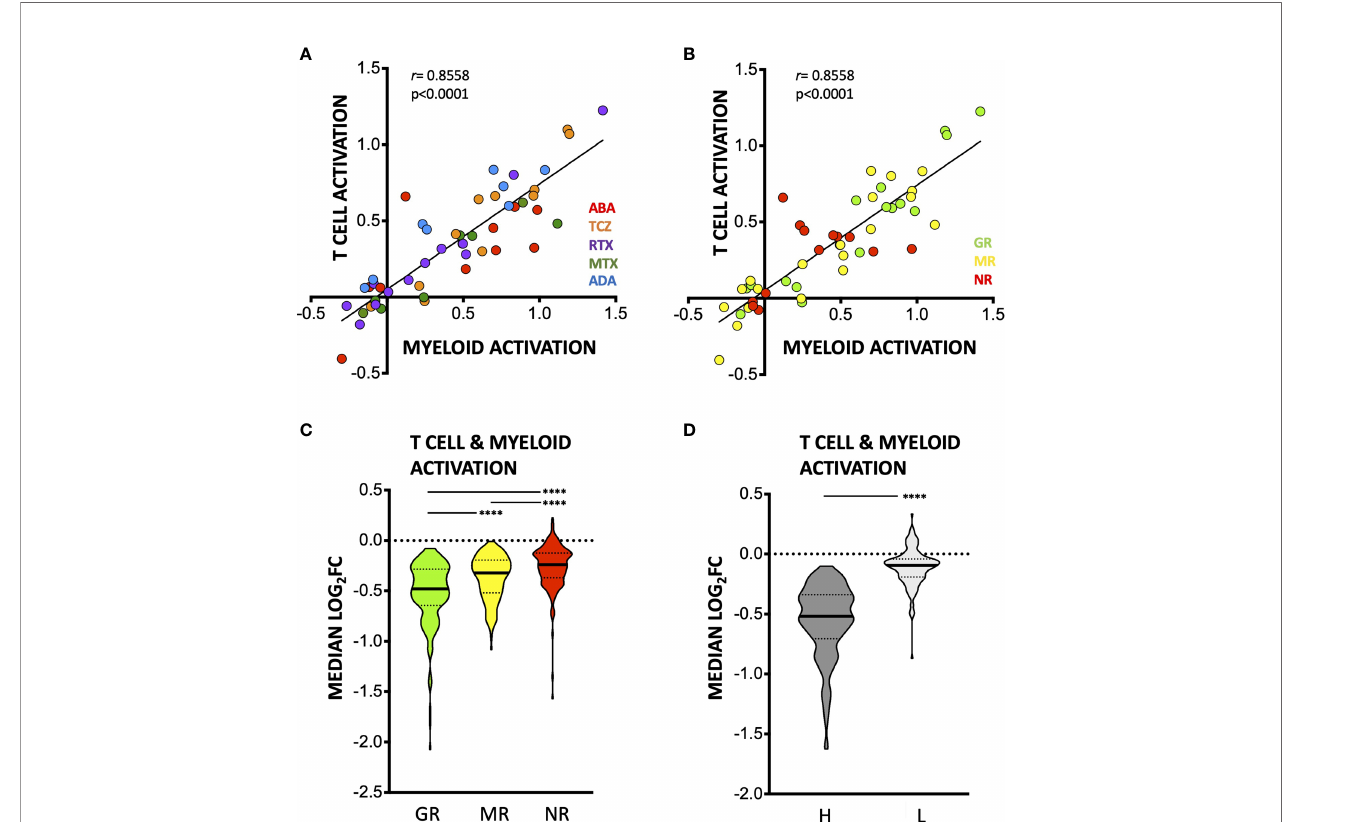
FIGURE 5 | Effects of DMARDs on T-cell and Myeloid Leukocyte Activation transcriptional signatures. (A, B) Median – (log 2 FC) in n = 80 T Cell activation genes (as de fi ned by Metascape) and n = 38 myeloid activation genes (as de fi ned by Metascape), colored by therapy (A) or by clinical response at time of 2 nd biopsy (B) . (C) Truncated violin plot (with median and interquartile range) of median log 2 FC in expression of (n = 118) T-cell and myeloid cell activation genes induced by DMARDs in groups with different EULAR response at 2 nd biopsy. **** p < 0.0001, Kruskal-Wallis with Dunn ’ s multiple comparison tests. GR, good responders; MR, moderate responders; NR, non-responders. (D) Truncated violin plot (with median and interquartile range) showing median log 2 FC in expression of T-cell and myeloid cell activation genes induced by DMARDs in samples classi fi ed as high (dark grey, n = 33) or low (light grey, n = 17) for T-cell and myeloid cell signatures (n = 118 genes) at baseline by unsupervised clustering (see Methods). ****p < 0.0001, Mann-Whitney